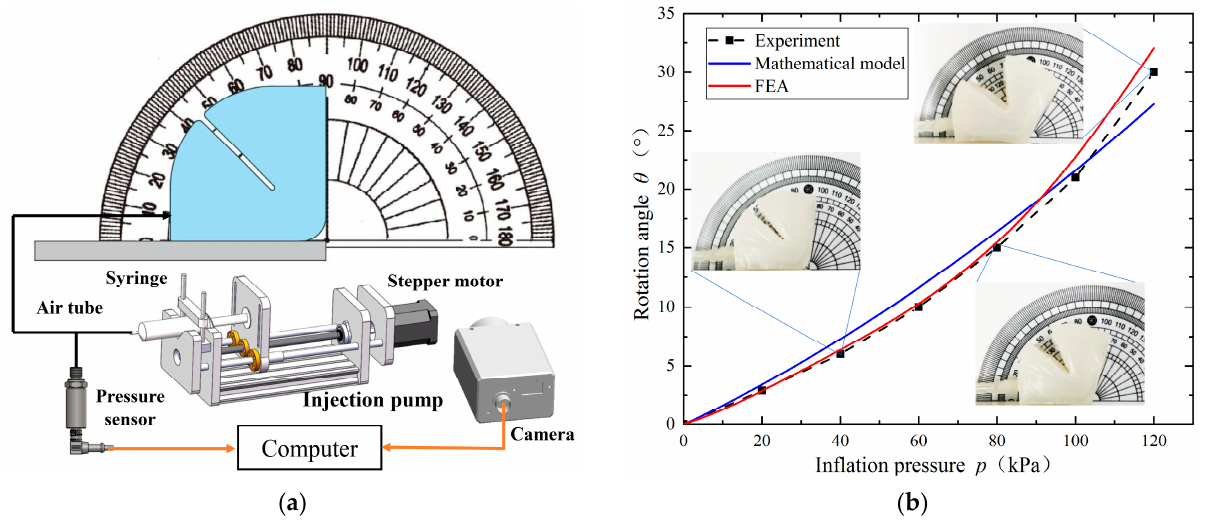
Figure 8. Rotation angle of flexible joint. ( a ) Experimental platform of rotation angle; ( b ) Comparison results.